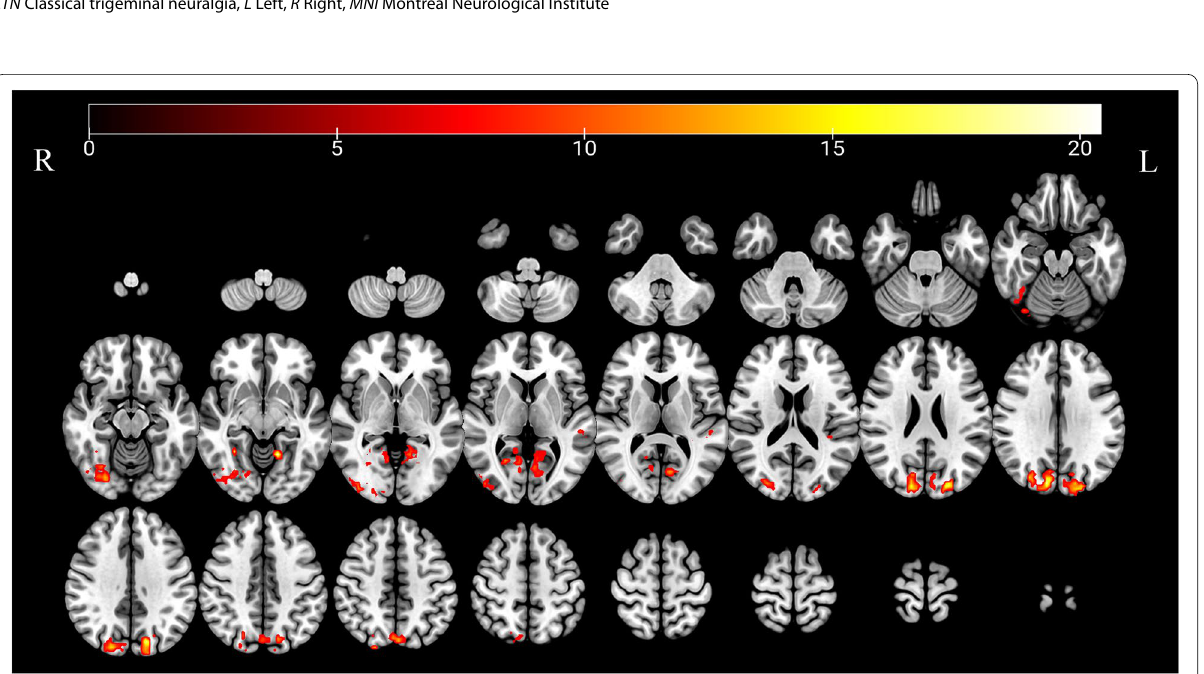
Baseline, the rs-fMRI was performed before stimulating the trigger zone; 5 s, the rs-fMRI was performed within 5 s after stimulating the trigger zone; 30 min, the rs-fMRI was performed in the 30th minute after stimulating the trigger zone CTN Classical trigeminal neuralgia, L Left, R Right, MNI Montreal Neurological Institute